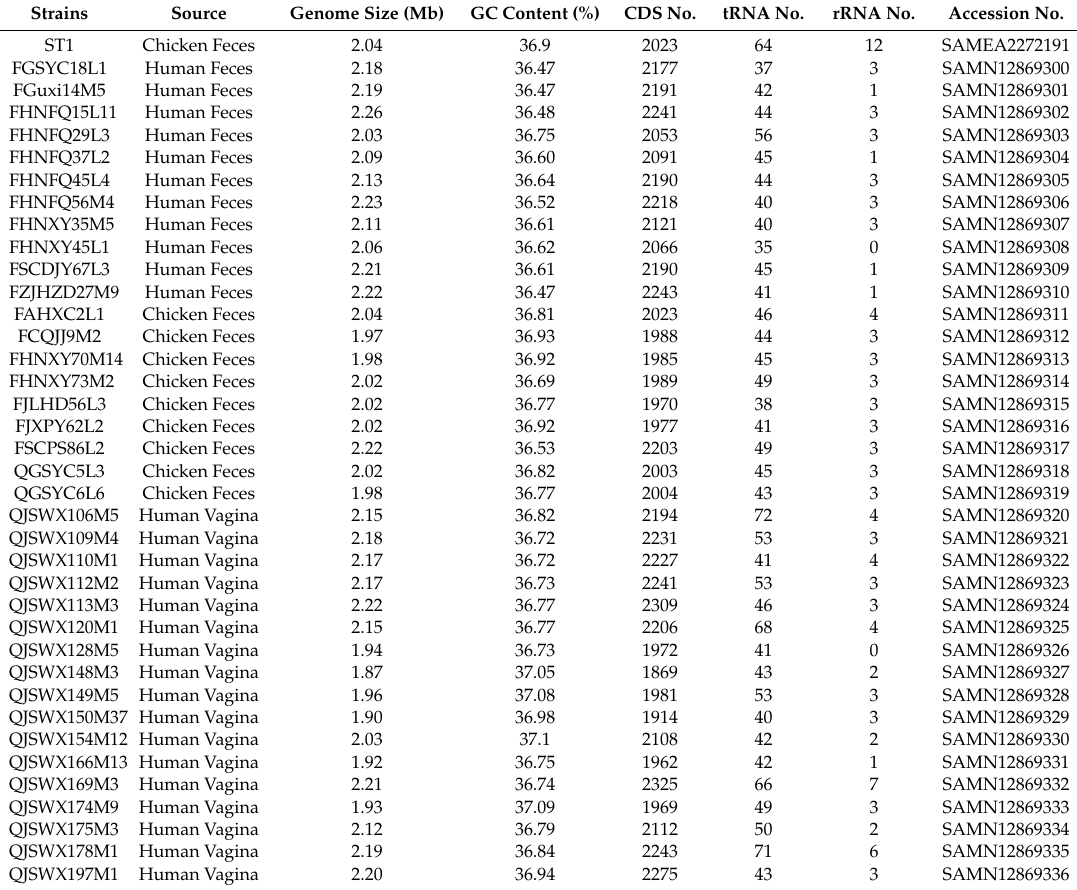
Table 1. General genome features of the 38 L. crispatus